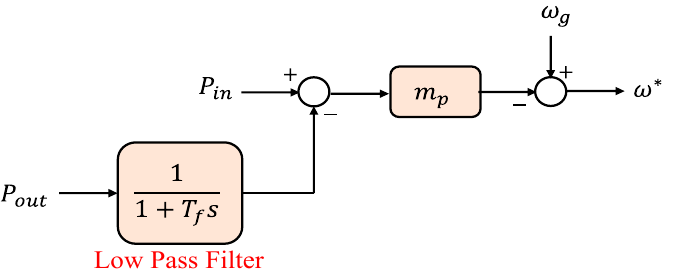
Figure 15. Frequency droop control [18]. Table 1. Key features of VSM